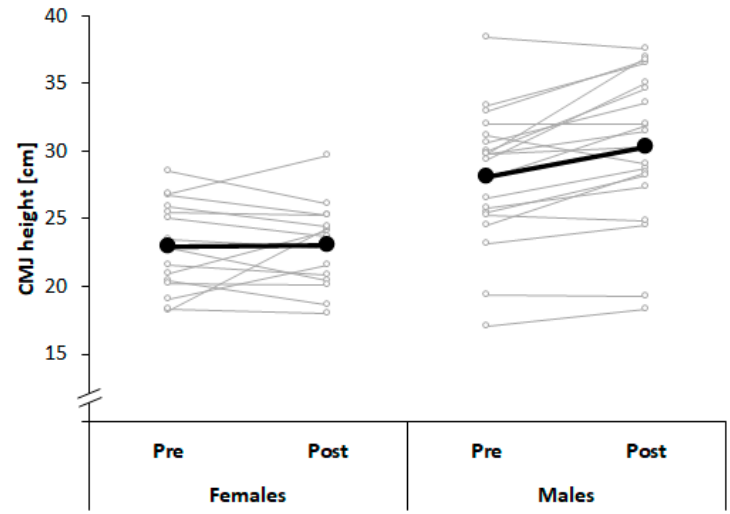
Figure 5. Changes in countermovement jump (CMJ) height across a period of 10 months of judo training in young male and female judo athletes.